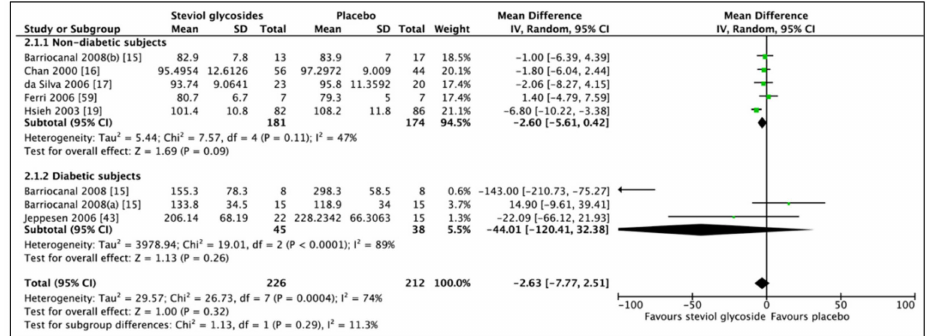
Figure 7. E ff ect of SGs on fasting blood glucose (FBG, mg / dL) CI: confidence interval; MD: mean di ff erence; RCTs: randomized controlled trials; SD: standard deviation.